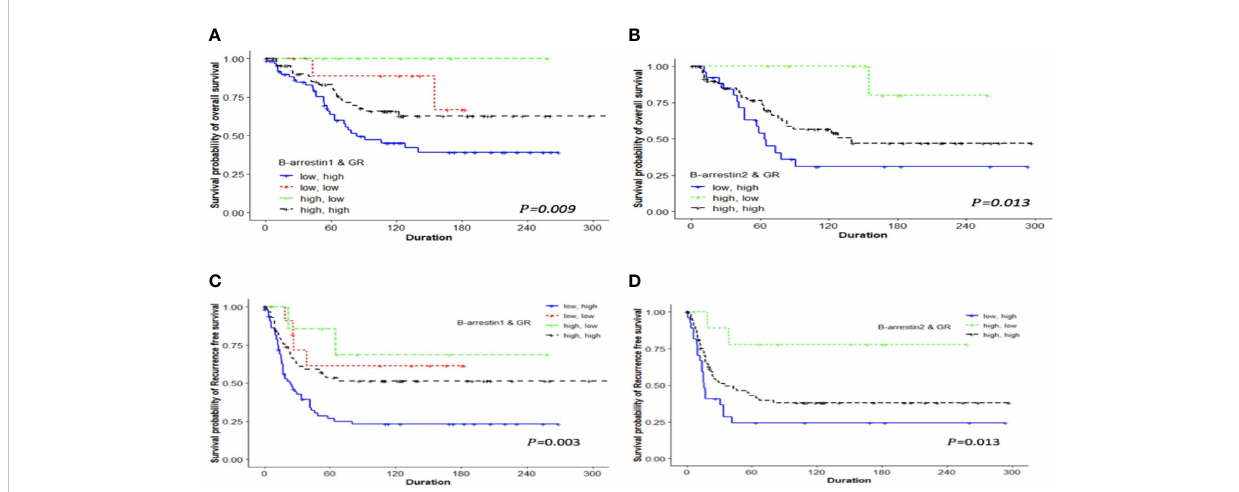
FIGURE 3 Kaplan – Meier analysis of patients with ovarian cancer based on the combination of b -arrestin 1, b -arrestin 2, and GR expression. OS and RFS differences were observed among the four groups classi fi ed according to high or low expression levels. (A) , The OS of patients with low b -arrestin 1 expression and high GR expression was shorter (median 63 months) than that of patients with high b -arrestin 1 expression and high GR expression (median 94 months), low b -arrestin 1 expression and low GR expression (median 138.5 months), or high b -arrestin 1 expression and low GR expression (median 85 months) (log-rank P = 0.009). (B) , Patients with low b -arrestin 2 expression and high GR expression had a signi fi cantly shorter OS (median 64 months) than those with high b -arrestin 2 expression and high GR expression (median 140 months) or high b -arrestin 2 expression and low GR expression (median not reached) (log-rank P = 0.013). (C) , The RFS of patients with low b -arrestin 1 expression and high GR expression was signi fi cantly shorter (median 18.5 months) than that of patients with high b -arrestin 1 expression and high GR expression (median 52 months), low b -arrestin 1 expression and low GR expression (median 106 months), or high b -arrestin 1 expression and low GR expression (median 66 months) (log-rank P = 0.003). (D) , Patients with low b -arrestin 2 expression and high GR expression had a signi fi cantly shorter RFS (median 16 months) than those with high b -arrestin 2 expression and high GR expression (median 35 months) or high b -arrestin 2 expression and low GR expression (median 118.5 months) (log-rank P =